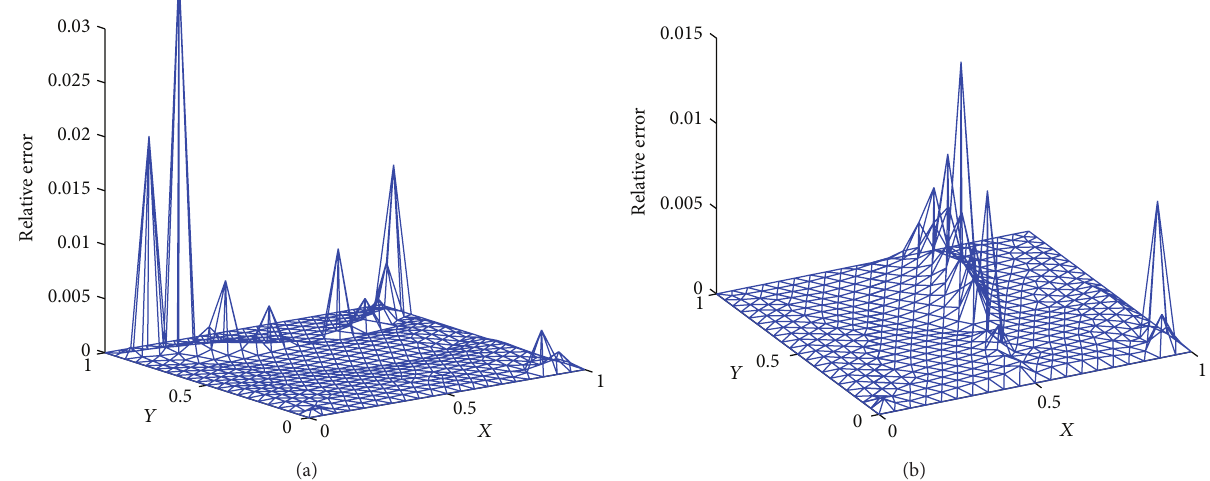
Figure 5: Relative error for horizontal (a) and vertical (b) velocity mean values using the stochastic solver and MC simulations for viscosity =